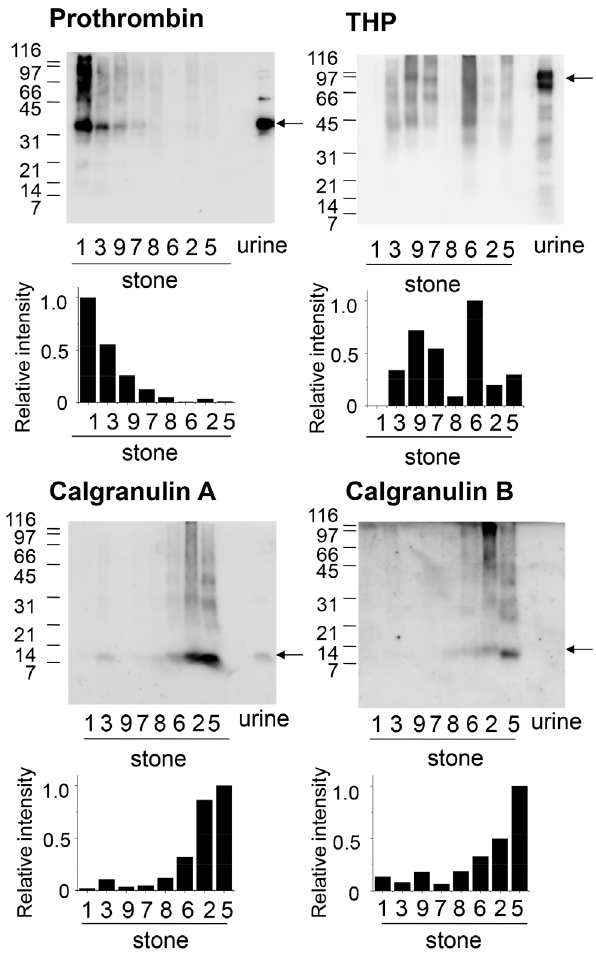
Figure 6. Western blot analysis of major proteins in CaOx kidney stones. Extracts of CaOx kidney stones containing 0.1 m g proteins were separated by SDS-PAGE and blotted on a PVDF membrane. To confirm the reactivity of antibodies and indicate the size of the proteins in urine, a concentrated urine sample from a normal subject (1 m g protein) was applied on the last lane of each gel. The membrane was then probed with anti-prothrombin fragment 1, anti- calgranulin A, anti-calgranulin B or anti-THP antibodies. Arrows indicate the positions of prothrombin fragment 1 (upper left), full length THP (upper right), full length calgranulin A (lower left), and full length calgranulin B (lower right). Western blotting was repeated two times and gave similar results. When Sample 1, 3, 9 and 7 (Group 1) was compared with Sample 8, 6, 2 and 5 (Group 2), p-value of Mann- Whitney U-test was 0.028 for prothrombin, calgranulin A and calgranulin B, while that for THP was 0.8857.